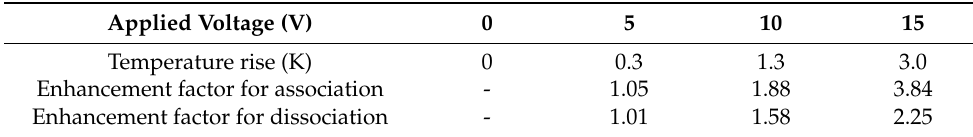
Table 6. Enhancement factor for association and dissociation phases and temperature rise.